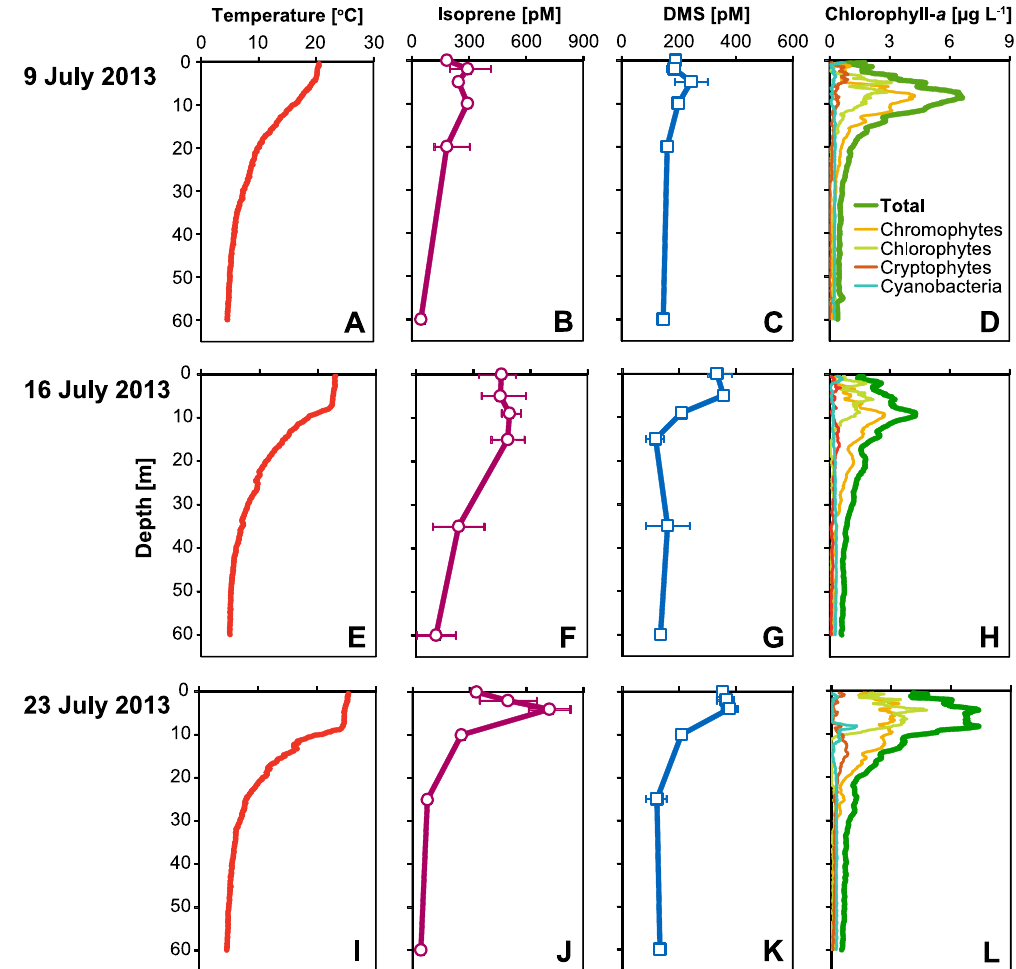
Figure 1. Depth profiles of temperature, isoprene, DMS and chl- a on 9, 16 and 23 July 2013. Concentrations of isoprene ( B , F , J ) and DMS ( C , G , K ) are shown as the arithmetic mean ± range of data (n = 2–3). Chl- a data ( D , H , L ) are shown as total and split based on fluorescence characteristics into four major phytoplankton groups (chromophytes, chlorophytes, cryptophytes, and cyanobacteria). Chl- a data were smoothed using a simple moving mean (running average) covering 0.80 ± 0.128 m